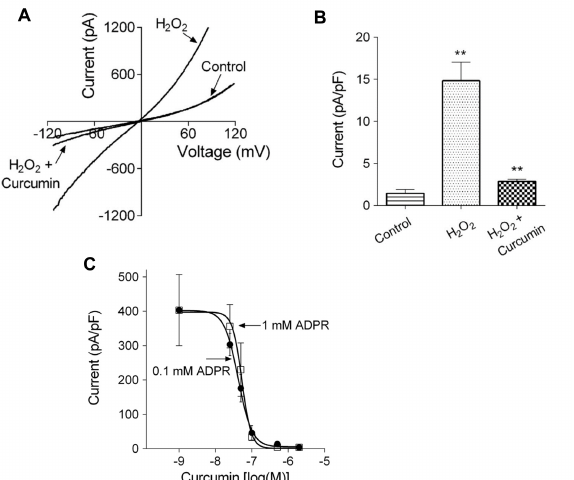
Figure 9. Curcumin inhibits TRPM2 non-selective cation channels, assayed by patch clamp recording, in isolated rat hepatocytes and in HEK293T cells heterologously expressing TRPM2. ( A ) Current– voltage plots for hepatocytes treated with H 2 O 2 to activate TRPM2, measured in the presence and absence of 5 µ M curcumin. ( B ) Average amplitude of the TRPM2-mediated Na + current in untreated hepatocytes (Control), hepatocytes treated with H 2 O 2 (H 2 O 2 ) and in hepatocytes treated with H 2 O 2 in the presence of 5 µ M curcumin (H 2 O 2 + Curcumin). ** P < 0.008 ( C ) Dose–response curves for the inhibition of the TRPM2 current activated by ADP-ribose (two concentrations administered via the patch pipette) to HEK293T cells heterologously expressing TRPM2. The IC 50 values for curcumin inhibition are about 50 nM. Reproduced with permission from [119], copyright 2016